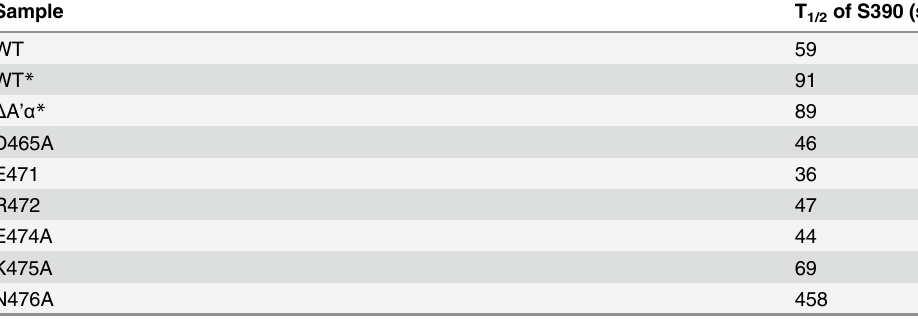
Table 1. Half decay times of the dark recovery from S390 to D450 at 20°C.